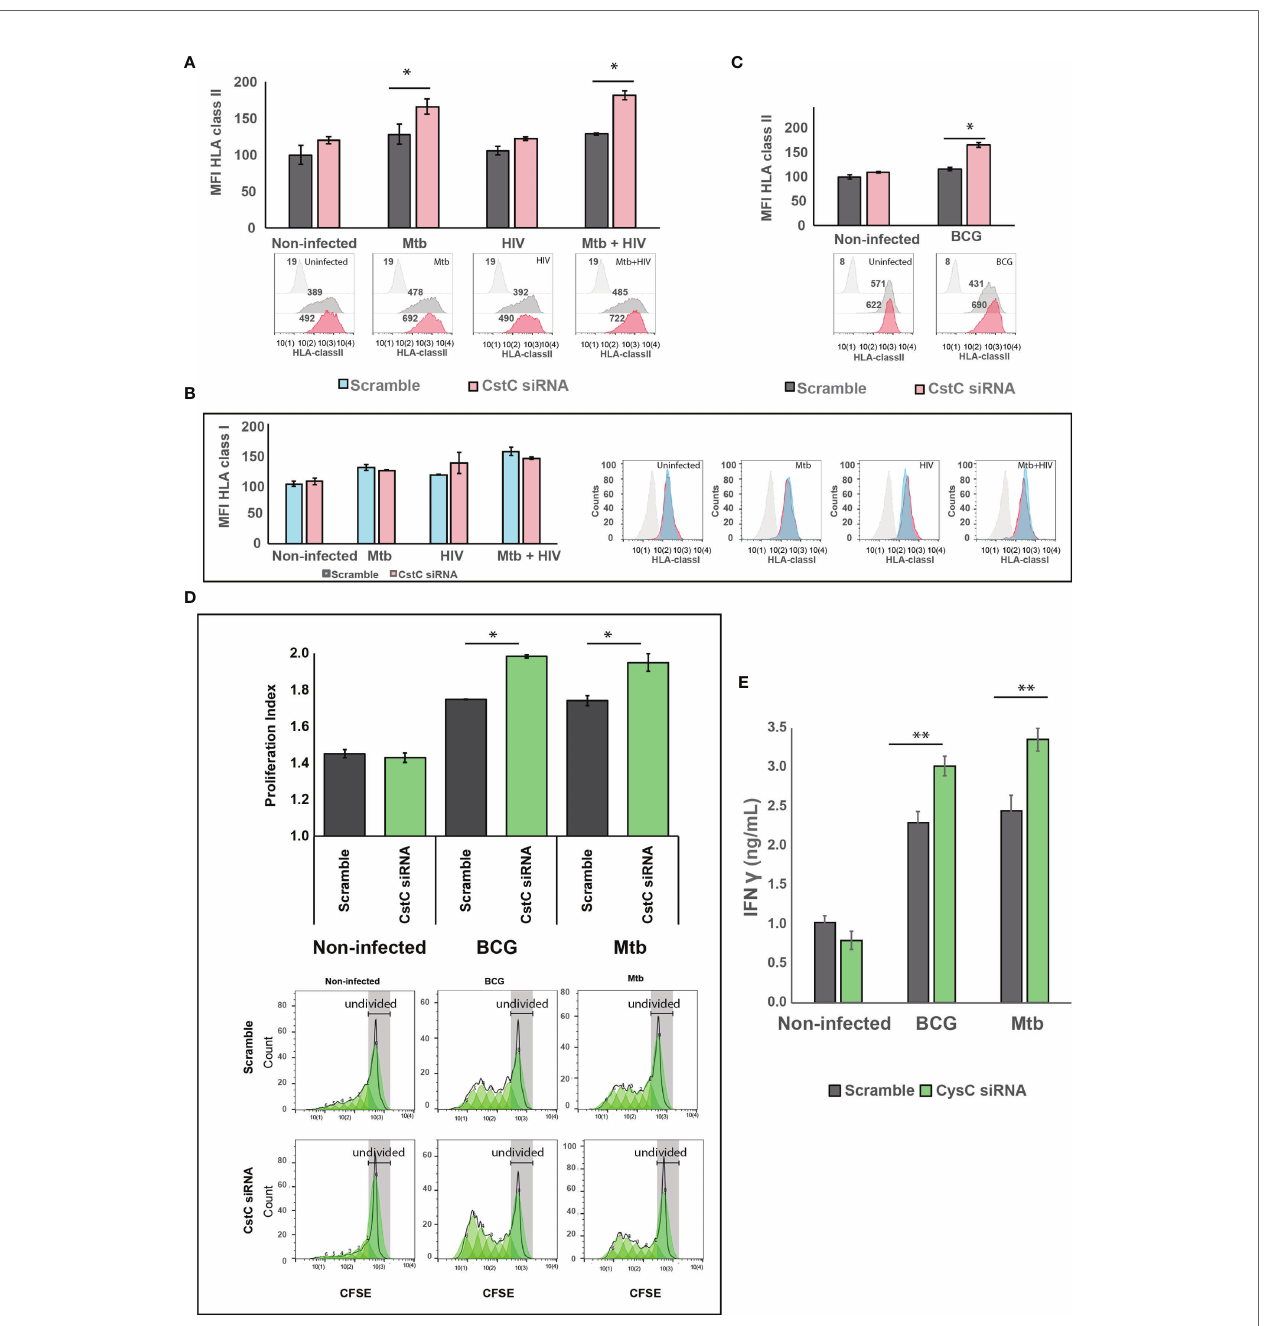
FIGURE 5 | SiRNA-mediated gene silencing for CstC results in increased cell-surface expression of MHC class II and elevated T-cell proliferation and proin fl ammatory IFN- g secretion. Cell-surface expression of human leukocyte antigen (HLA) class II (A, B) or class I (C) on Mø transfected with siRNA for CstC or with a scramble siRNA in the different infection challenges compared with non-infected cells. HLA class II and I were measured by fl ow cytometry after 24 h of infection. Values in bar plots represent median fl uorescence intensity (MFI) relative to the respective scramble controls from one representative experiment performed in triplicate, while error bars depict the standard deviation (* p < 0.01; n = 3). (D) CD4 + T-cell proliferation after 5 days of coculture with Mtb- or BCG-infected Mø. Infected Mø were cocultivated with CFSE-stained CD4 + T cells following 24 h of infection. After 5 days of coculture, CD4 + T-cell CFSE fl uorescence was measured by fl ow cytometry. Values in bar plots represent the proliferation index (average number of divisions per cell) of CD4 + T cell (* p < 0.01, relative to scramble control; n = 3). Histograms from one representative replicate of the different treatments infected with Mtb are presented at the bottom. The green areas represent the CD4 + T cell populations after each division, as modeled by the software. Each generation is identi fi ed by a 50% decrease in fl uorescence caused by cell division. (E) IFN- g was quanti fi ed in the supernatant after 5 days of cocultures of Mø with CD4 + T cells by ELISA. Values depict mean concentration of three biological replicates from one representative experiment performed in duplicate. Error bars depict the standard deviation (** p < 0.001, relative to control; n = 3). Mtb, Mycobacterium tuberculosis ; Mø, macrophages; CFSE, carboxy fl uorescein succinimidyl